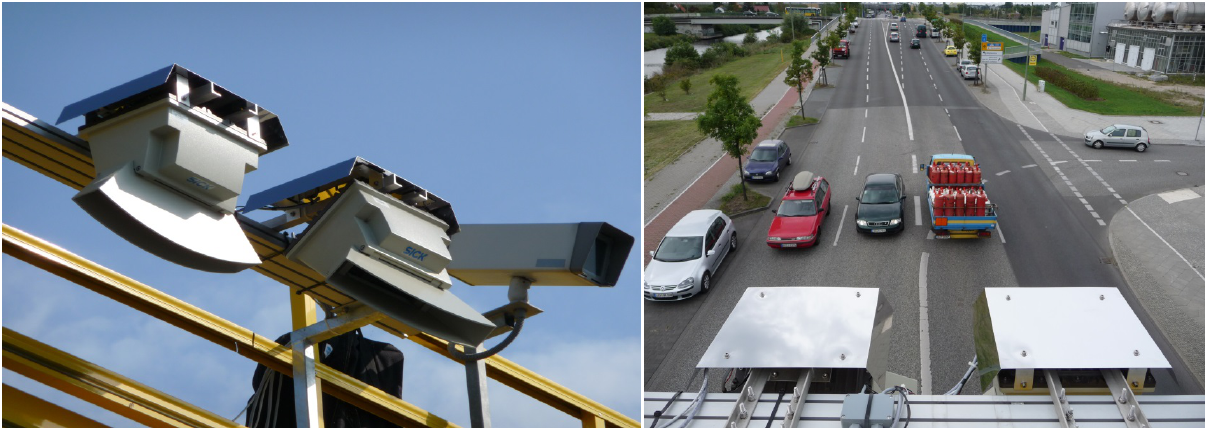
Figure 5: Profiling laser scanners.